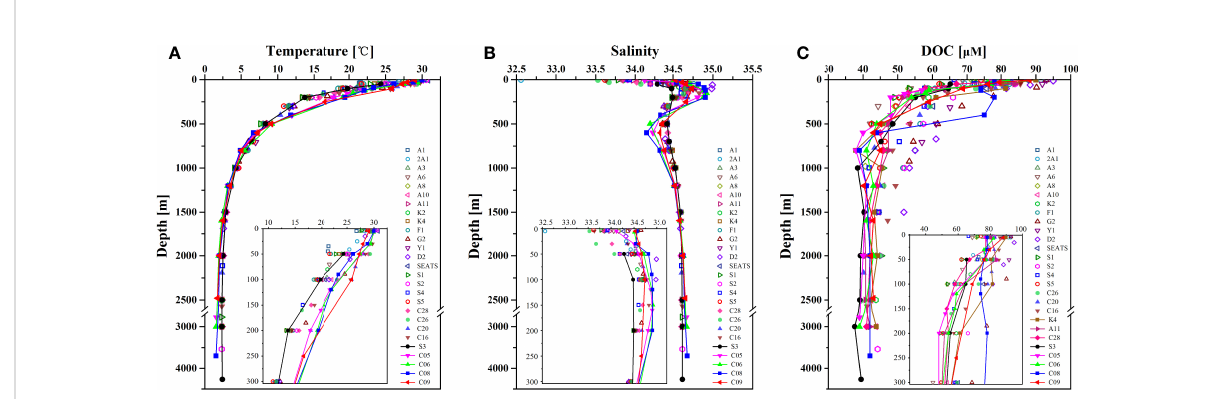
FIGURE 2 Depth pro fi les of (A) water temperature, (B) salinity, and (C) DOC concentrations measured at the 27 stations in the northern SCS and western NP during three cruises in 2015, 2016 and 2019 in this study and a previous report, as described in Figure 1. The depth below 2,500 m is on a different scale, and the inset fi gures show pro fi les in the upper 300 m depth. Note that the hydrographic data and DOC concentrations for eight stations (S1, S2, S3, D2, A11, K2, C05 and C08) were collected on the same cruises and have been previously published (Ding et al., 2020). These data are cited for comparison with the 19 stations in this